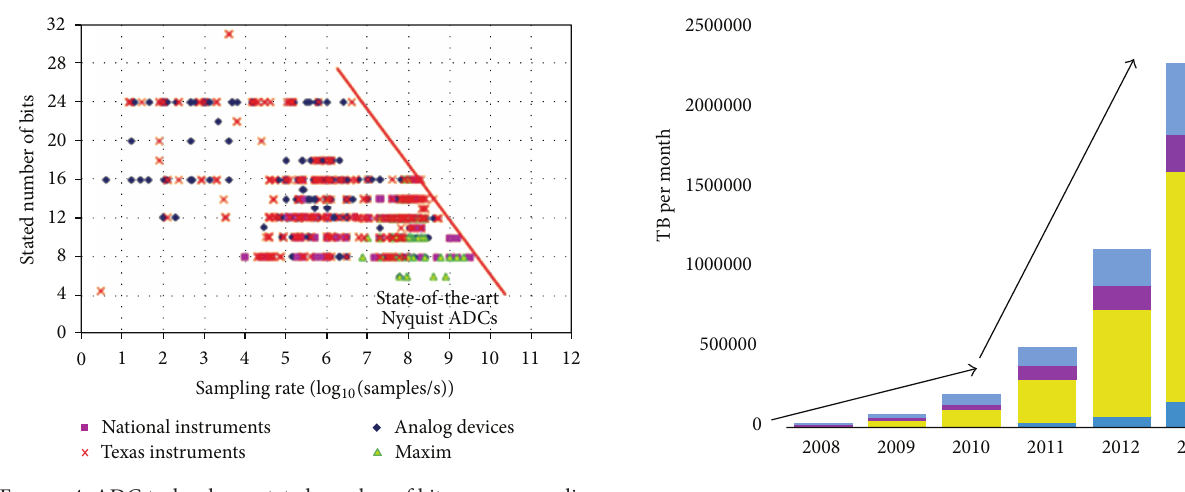
Figure 4: ADC technology: stated number of bits versus sampling rate. A map of more than 1,200 ADC devices from four leading manufacturers, according to online datasheets [17].